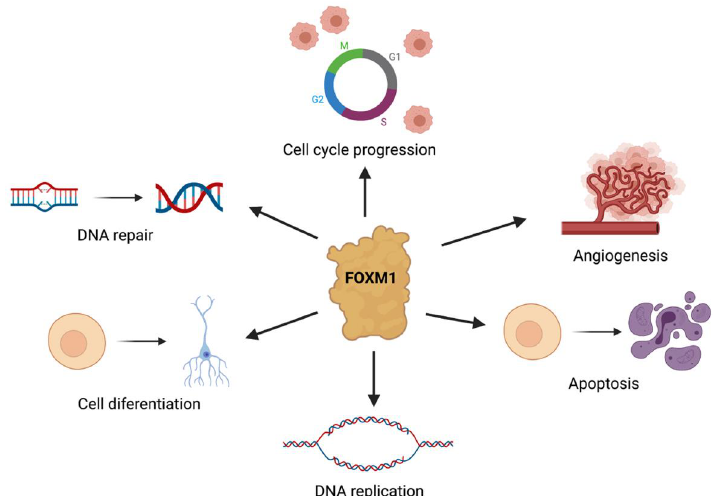
Figure 1. The role of FOXM1 in cancer initiation and cancer progression. FOXM1 is involved in cell proliferation, cell-cycle progress, cell differentiation, DNA replication, DNA-damage repair, tissue homeostasis, angiogenesis, and apoptosis.